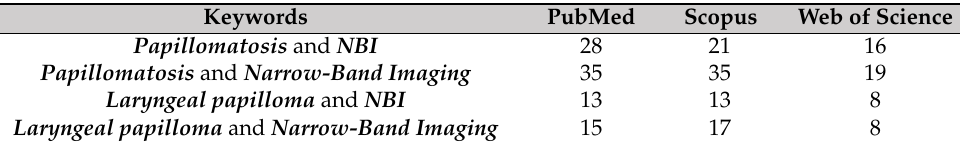
Table 1. Number of articles based on keywords search strategy on